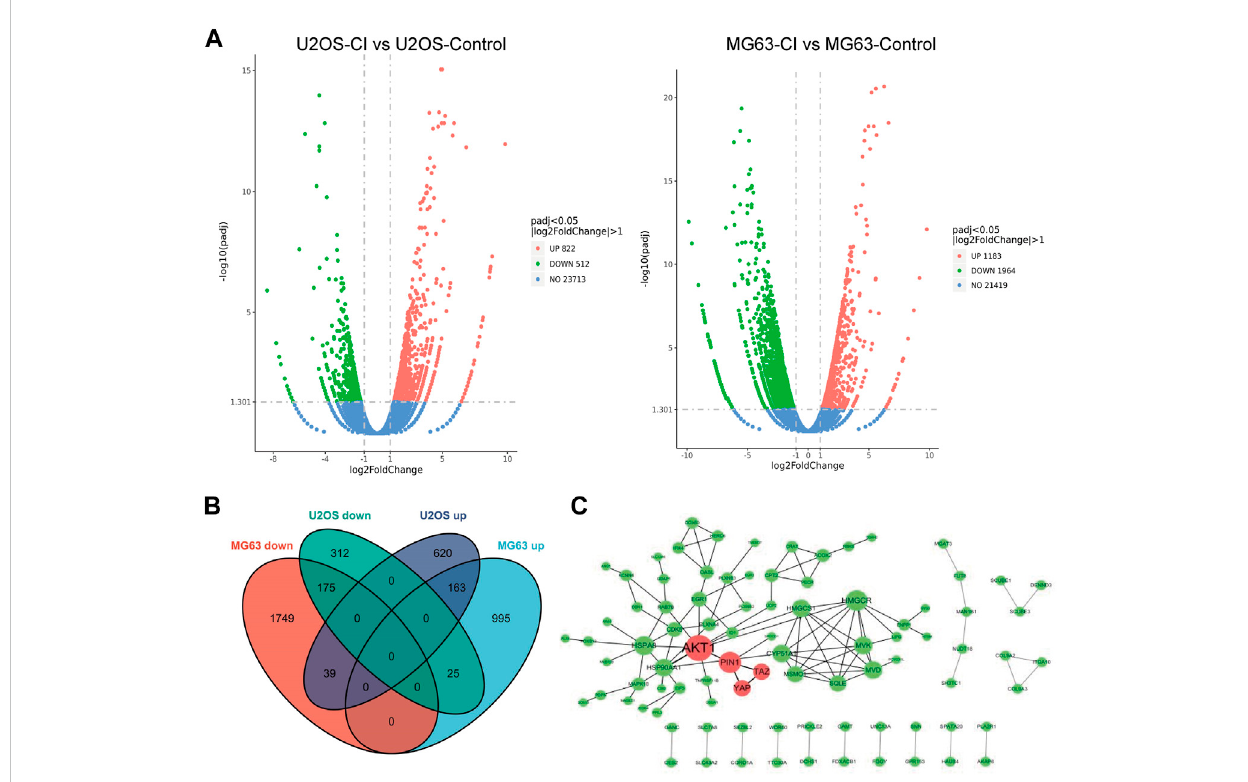
FIGURE 4 AnalysisofCI-regulatedgeneexpressioninOScells. (A) Volcanoplotofthelog2FoldChangeCI/controlvs.the-log10 p -value(y-axis)ofthegenes inU2OS and MG63 cells. (B) The intersection of differentially expressedgenes betweenU2OS and MG63 cells wererecognized as commondifferentially expressedgenes. (C) PPI interactions of the co-downregulated genes were analyzed by Cytoscape software (the larger the node, the higher the degree). The red nodes represented the core position of the PPI